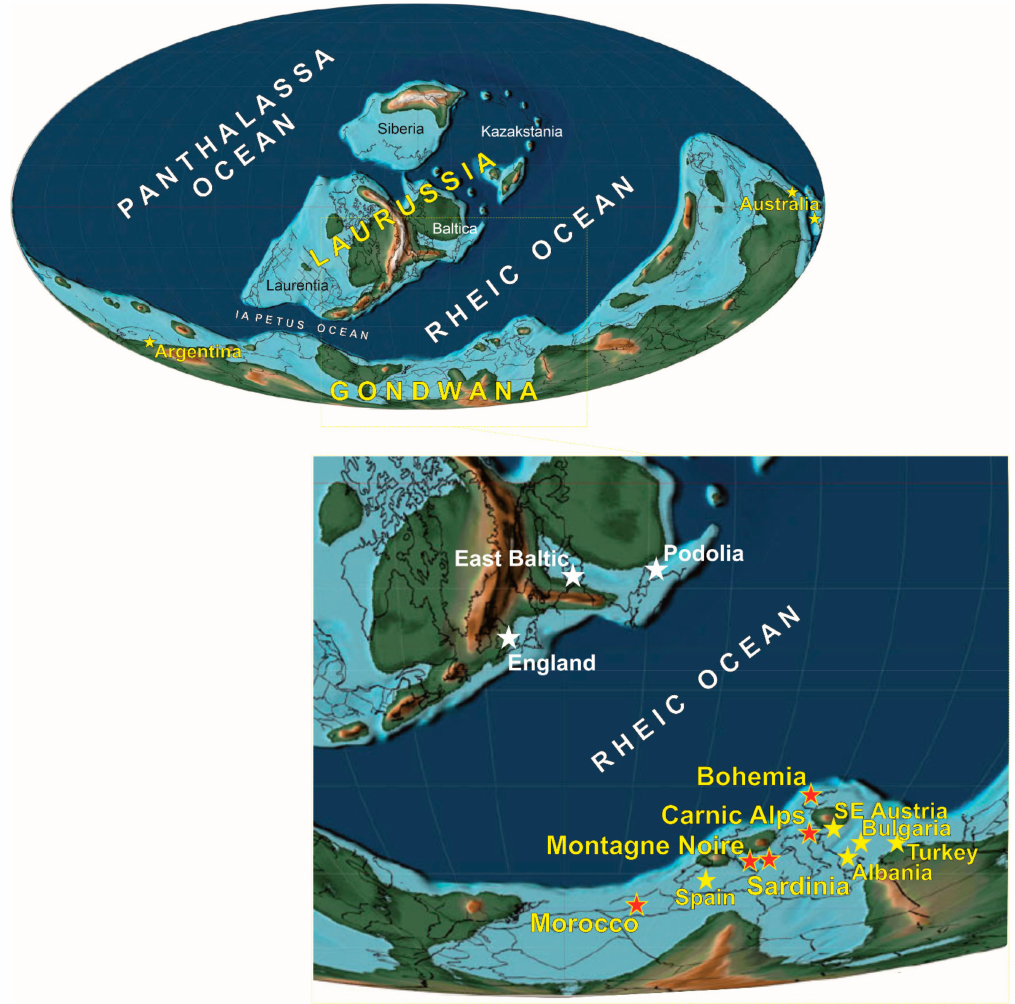
Figure 3. Palaeogeographical distribution of published conodont records across the Sil- urian/Devonian boundary along northern Gondwana. Stars indicate data analysed in the present paper, with red stars pointing to collections studied directly by the Authors. Palaeogeographical reconstruction after Scotese (2014)